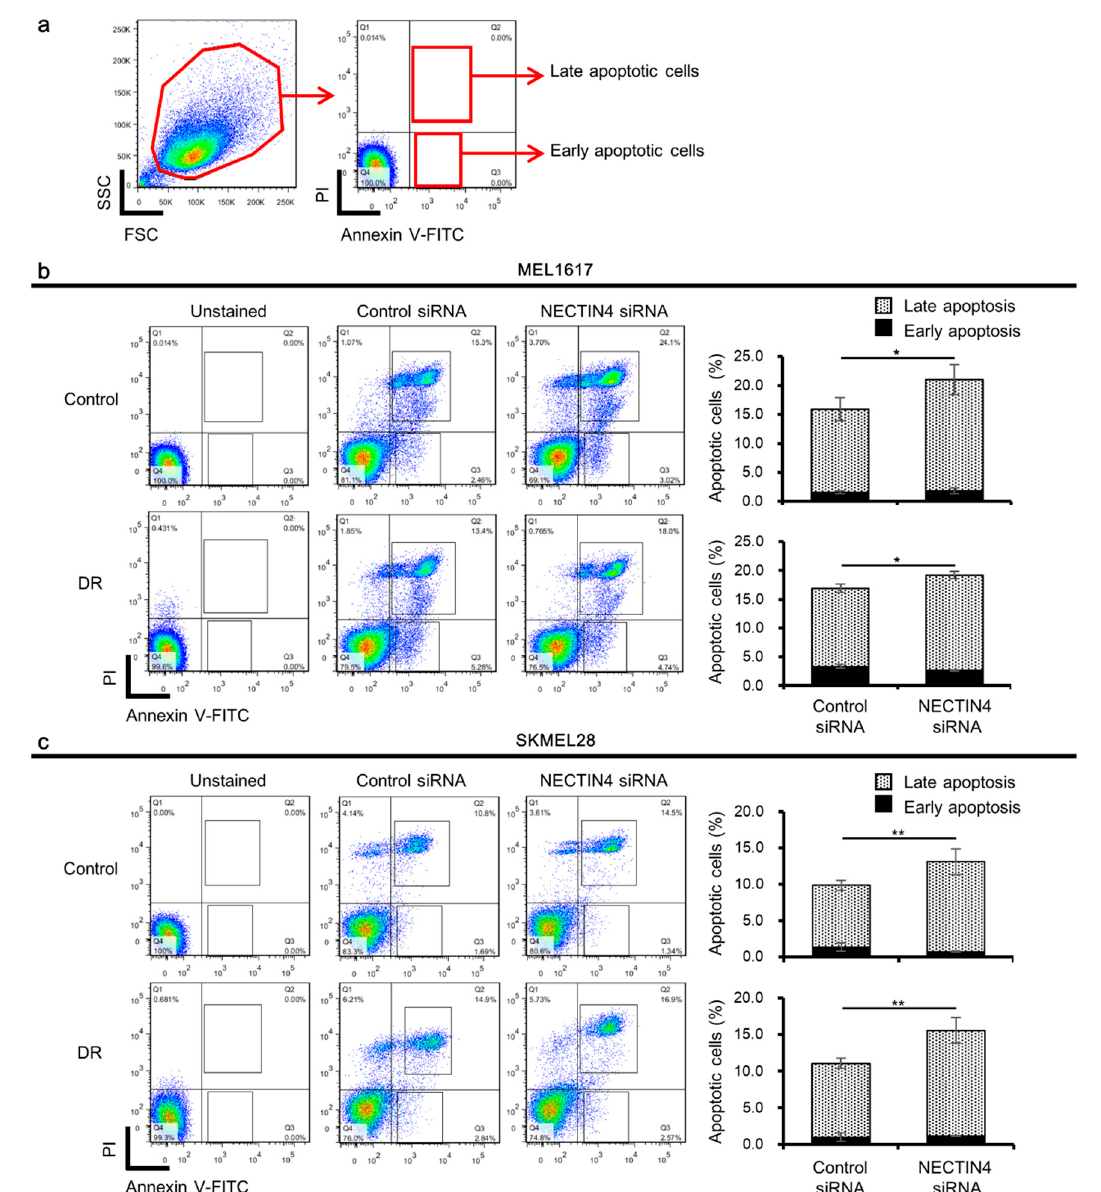
Figure 4. NECTIN4 is involved in the regulation of apoptosis in BRAFi-resistant melanoma cells. ( a ) Gating strategy of flow cytometric analysis. Non-specific signals were removed by the first gate. The gated fraction was further expanded with Annexin V-FITC and PI, and analyzed for the percentage of late (Annexin V-positive PI-positive) and early (Annexin V-positive PI-negative) apoptotic cells. Representative flow cytometric images (left panels) and the percentage of apoptotic cells among all cells (right panels) of ( b ) MEL1617 and ( c ) SKMEL28, and their DR cell lines are shown ( n = 3). Data are presented as the mean ± standard deviation of three independent experiments. * p < 0.05 and ** p < 0.01 determined by Student’s unpaired two-tailed t -test.